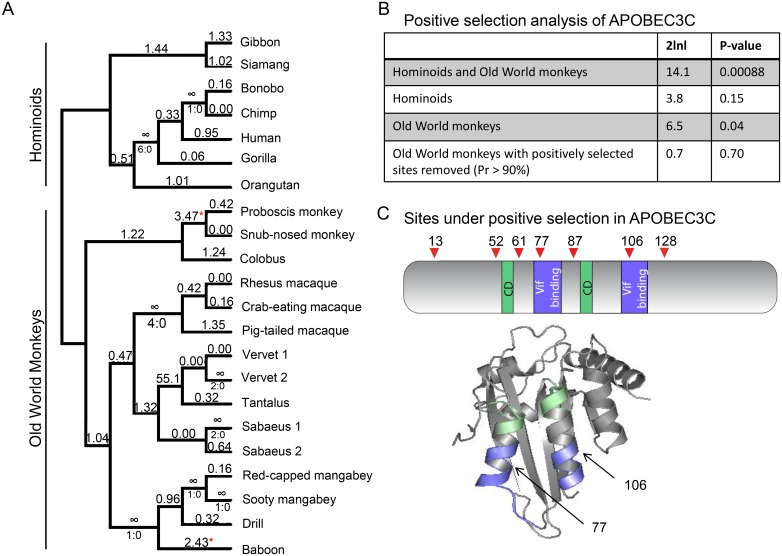
APOBEC3C is rapidly evolving in primates.(A) Twenty-two primate APOBEC3C coding sequences were obtained by PCR or from the NCBI sequence database. A phylogeny of APOBEC3C, indicating the branch analysis results of the positive selection tests. The ratio of rate of nonsynonymous changes (dN) and the rate of synonymous changes (dS) that occurred along each branch are shown above each branch. For dN/dS values = ∞, the total number of non-synonymous changes (N) and synonymous changes (S) are shown (N:S) below the branch. The red asterisks mark the branches where the dN/dS is significantly greater than 1 across the entire gene. (B) Maximum likelihood tests for positive selection, with 2lnl values indicating twice the log difference between the model that allows for positive selection (M8) and the model that does not allow for positive selection (M8a), as well as a P-value to indicate whether the M8 model better fits the data than the M8a model. (C) Sites under positive selection in APOBEC3C are shown in a cartoon diagram, comparing these sites to the Vif binding domain and the cytidine deaminase enzymatic domain (CD). Red triangles depict sites with a posterior probability >0.99 (red triangle). The structure of APOBEC3C[31] is represented, with the Vif binding domain[31] shown in blue. Two of the seven positively selected sites (PP > 0.99) overlap with this domain, are shown with arrows. The cytidine deaminase domain is shown in green.